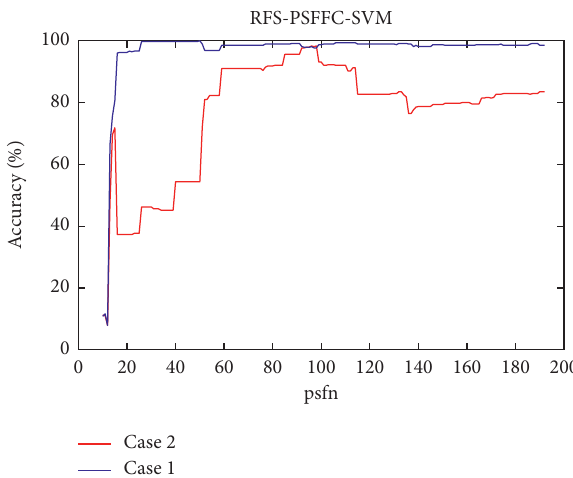
Figure 14: The testing accuracies of RFS-PSFFC-SVM with dif- ferent psfn